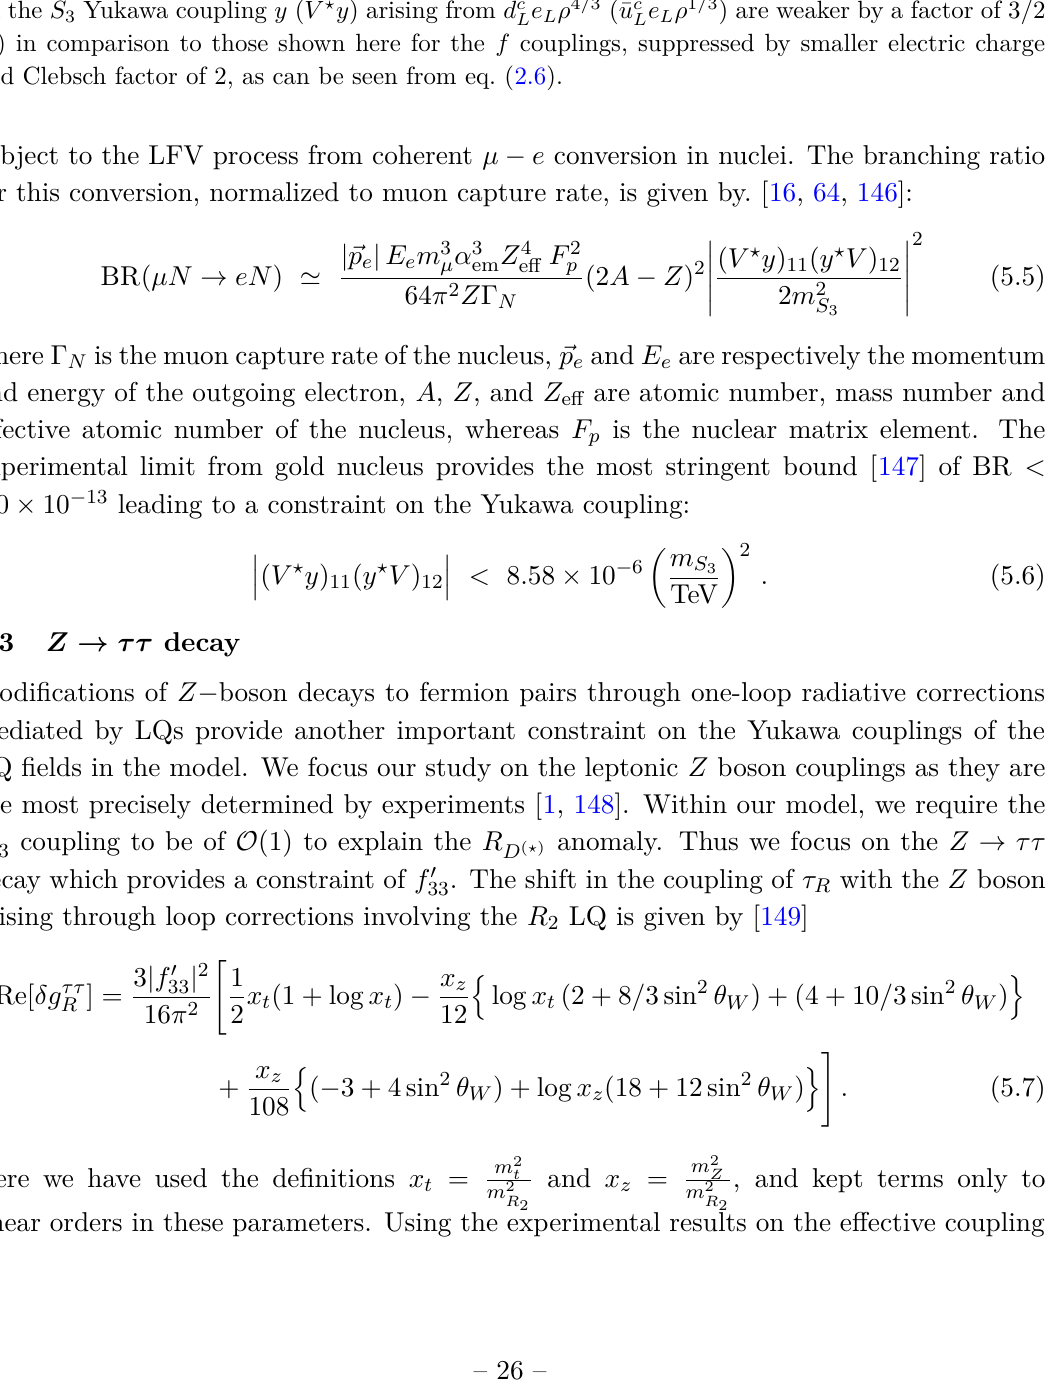
e L ρ 4 / 3 ( ¯ u c e L ρ 1 / 3 ) are weaker by a factor of 3/2 L L